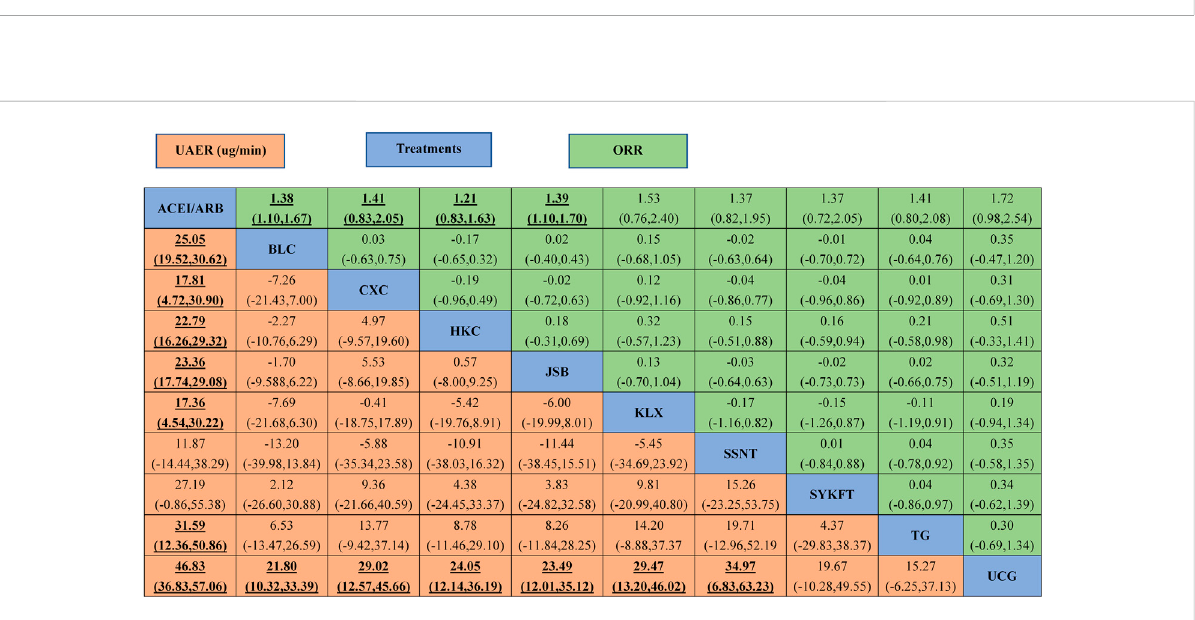
FIGURE 3 Forest plots of primary outcomes. BLC, Bailing capsule; JSB, Jinshuibao capsule; HKC, Huangkui capsule; UCG, uremic clearance granule; TG, tripterygium glycosides; CXC, Compound Xueshuantong capsule; SYKFT, Shenyan Kangfu tablet; KLX, Keluoxin capsule; SSNT, Shenshuaining tablet; ACEI, angiotensin-converting enzyme inhibitor; ARB, angiotensin receptor blocker; UAER, urinary albumin excretion rate; ORR, overall response rate; Scr, serum creatinine; 24 h UTP, 24 h urinary total proteins.